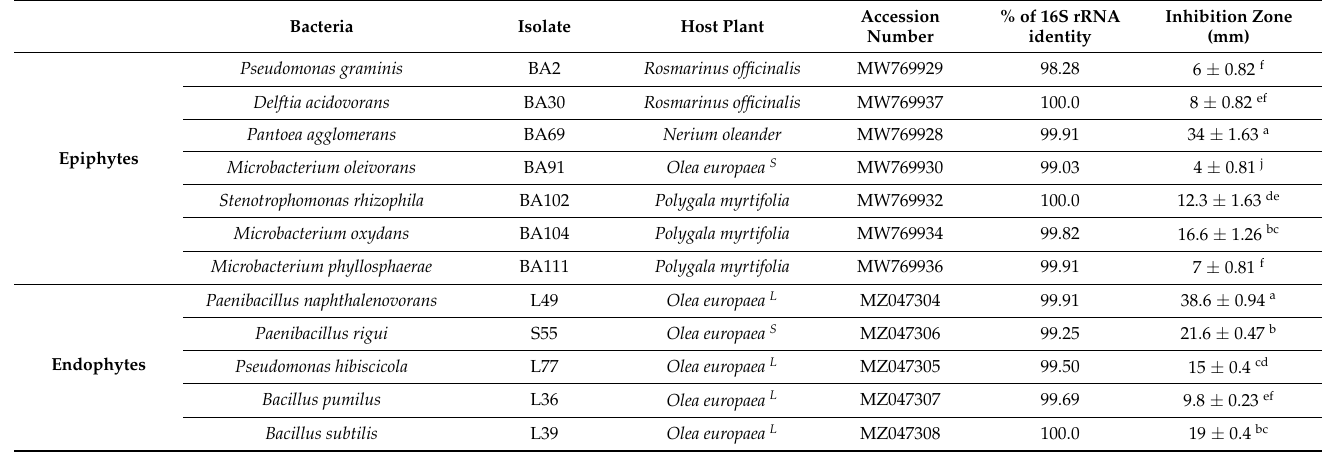
Table 1. Epiphytic and endophytic bacteria isolates and their antagonistic activities against X. fas- tidiosa ST53. Different letters indicate statistically different antagonistic activities of epiphytic and endophytic isolates with p < 0.05 as determined by one-way analysis of variance (ANOVA) followed by Tukey’s